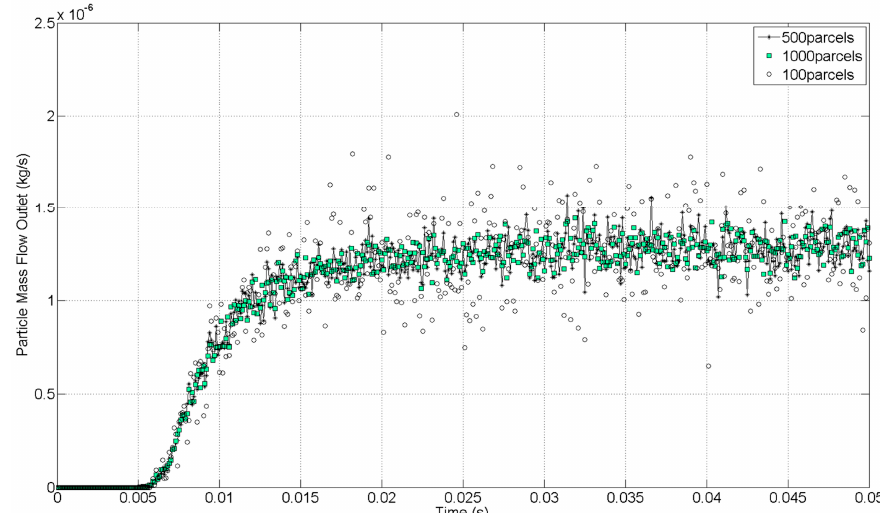
Figure 7. Particle mass imbalance at the outlet with different numbers of computational parcels.